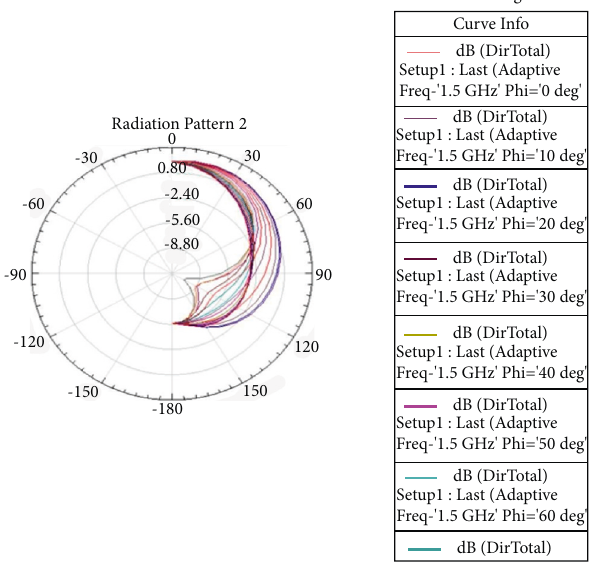
Figure 11: Radiation pattern 2 of designed circular patch antenna.